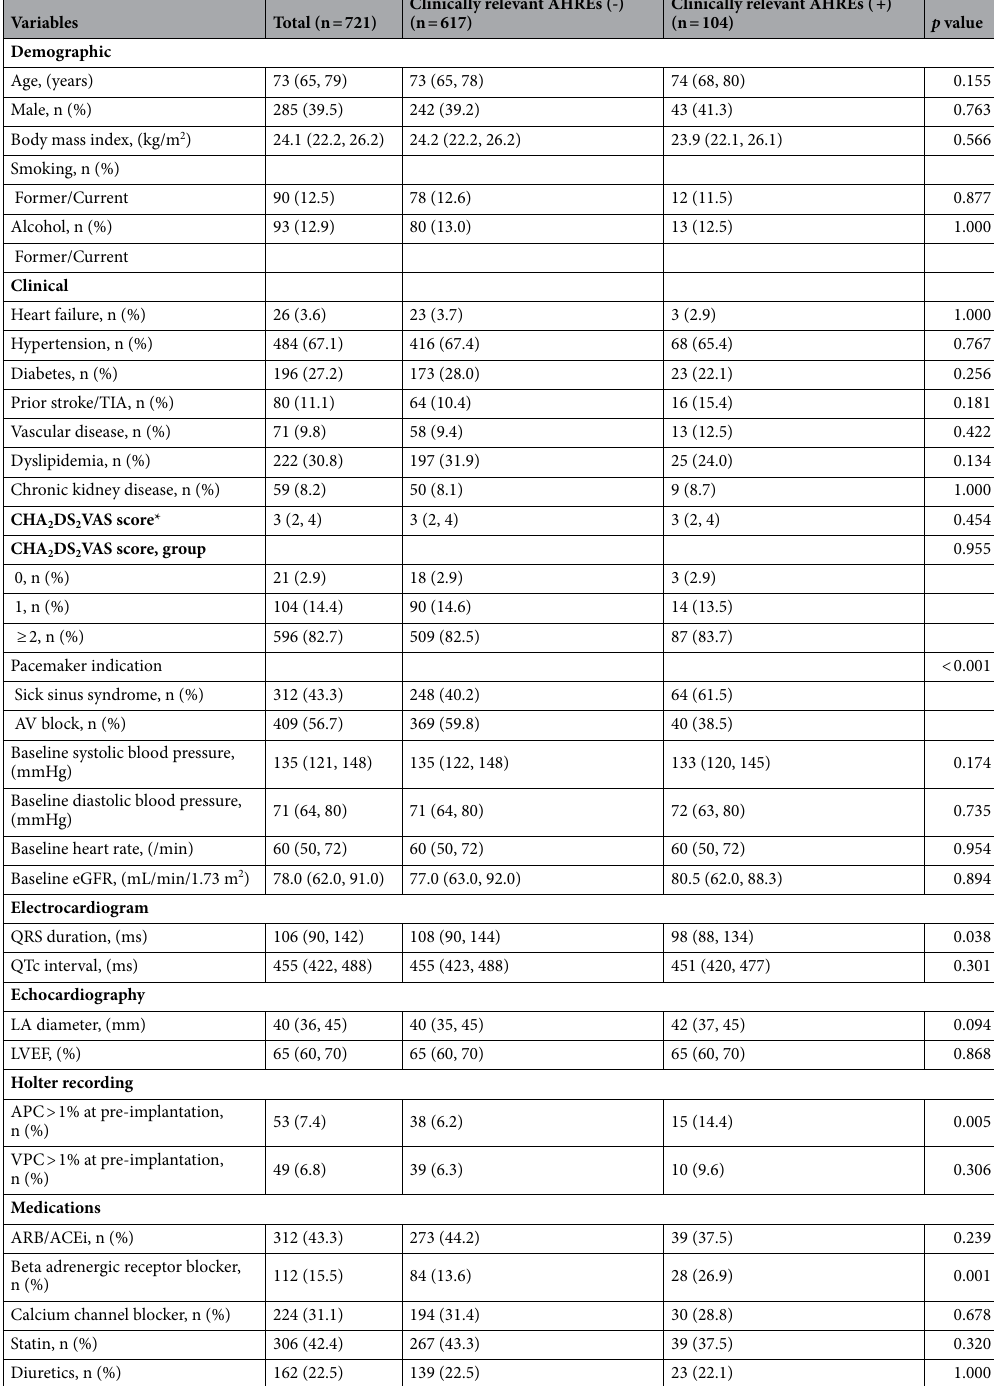
Table 1. Baseline characteristics of the patients with and without clinically relevant AHREs. The data are presented as number (%), median [IQR]. ACEi angiotensin-converting-enzyme inhibitor, AHREs atrial high- rate episodes, APC atrial premature complex, ARB angiotensin receptor blocker, AV atrioventricular, GFR glomerular filtration rate, LA left atrium, LVEF left ventricular ejection fraction, QTc corrected QT, TIA transient ischemic attack, VPC ventricular premature complex. *The CHA 2 DS 2 -VAS score is a measure of the risk of stroke in patients with atrial fibrillation, with scoring ranging from 0 to 9 and higher scores indicating greater risk. Congestive heart failure, hypertension, age 75 years or older (doubled), diabetes, stroke (doubled), vascular disease, age 65 to 74 years, sex category